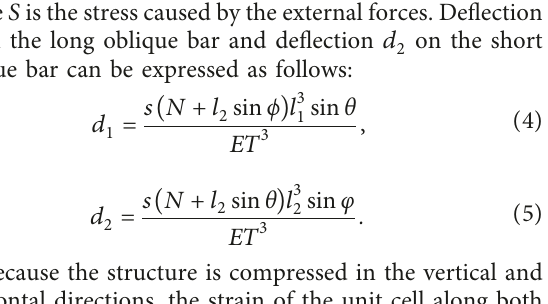
Figure 2: Schematic of negative Poisson’s ratio structure. (a) Designed negative Poisson’s ratio structure and (b) unit cell structure and (c) equivalent mechanical model